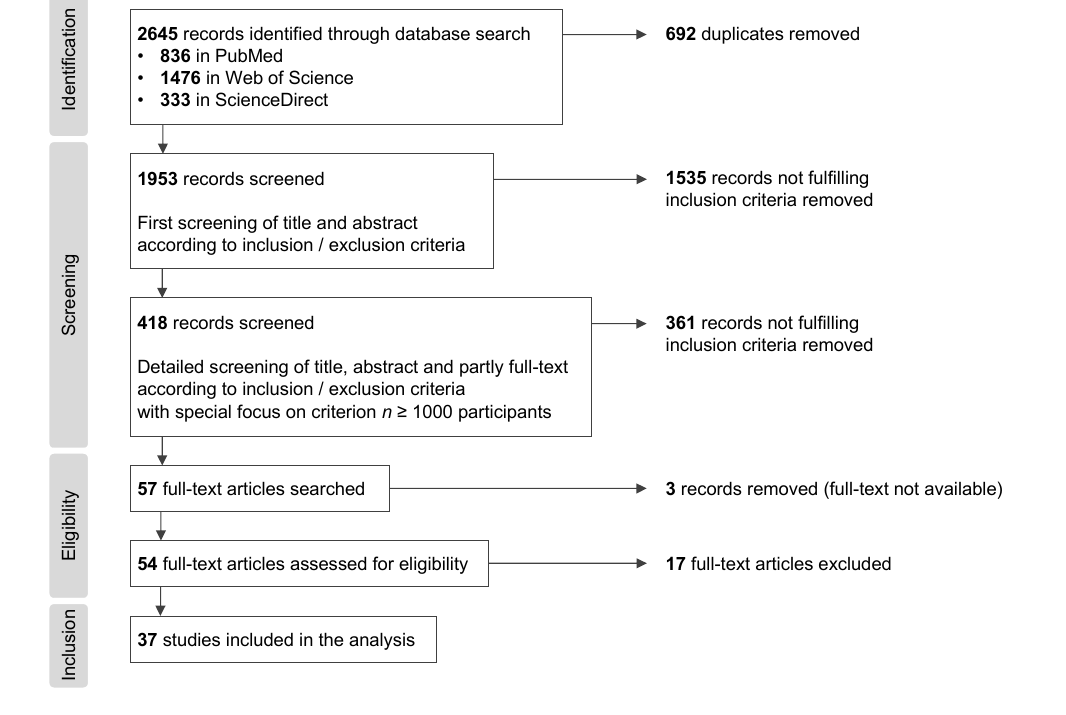
Figure 1. Flow chart of the systematic literature review according to the PRISMA statement [49] (own illustration). Table 1. Results of the systematic literature review on CAM, dietary supplement, and vitamin use among cancer